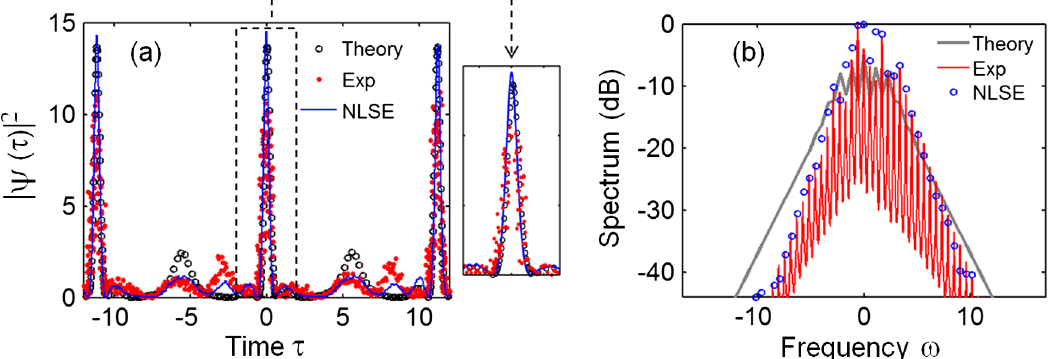
FIG. 7. (a) Experimental collision (red points) profile compared to ideal theory and NLSE simulations with nonideal excitation by using normalized variables. Note that the experimental profile has been normalized here to the average output power. The experimental giant wave reaches almost 11 at maximum, as shown by the zoom on the main peak. (b) Corresponding spectral characteristics from experiment (red) and NLSE simulation (blue circles, shown at peaks only for clarity) and for the ideal higher-order solution